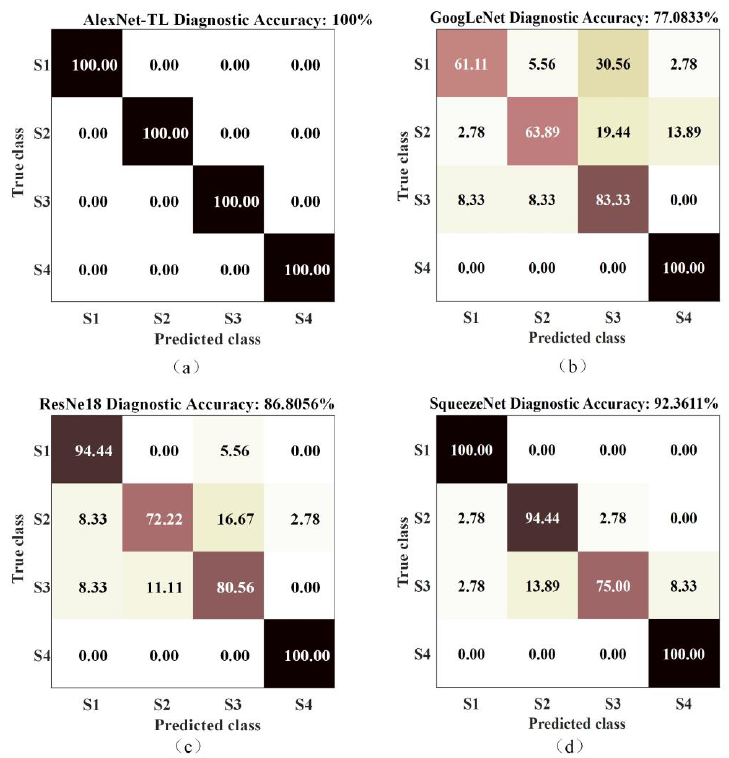
Figure 15. Fault diagnosis results of different network models: ( a ) AlexNet − TL = 100.0%; ( b ) GoogLeNet = 77.0833%; ( c ) ResNet18 = 86.8056%; ( d ) SqueezeNet = 92.3611%.